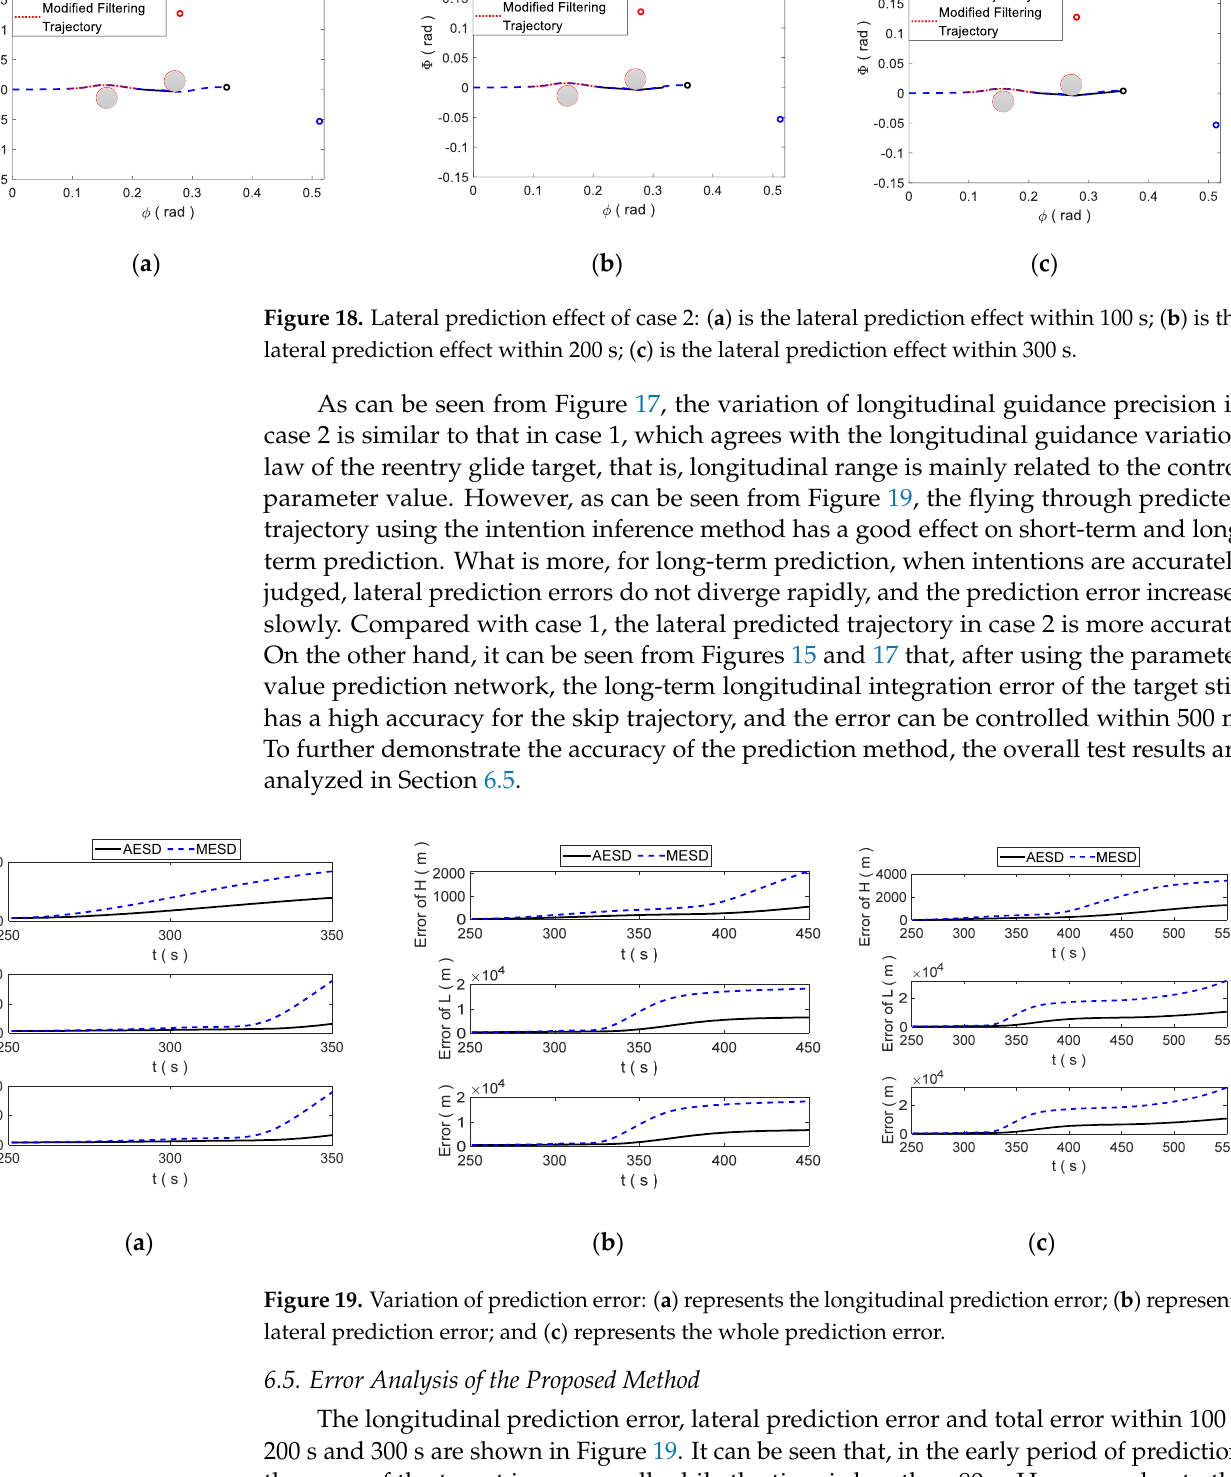
Figure 17. Longitudinal prediction effect of case 2: (a) is the longitudinal prediction effect within 100s; (b) is the longitudinal prediction effect within 200s; and (c) is the longitudinal prediction ef- fect within 300s.